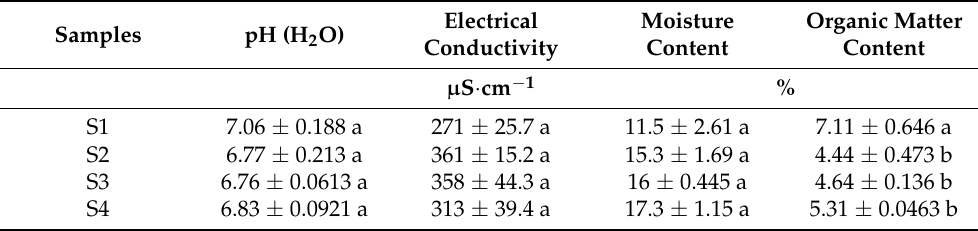
Table 1. Soil analyses (samples collected at depth of 0–30 cm) of Triticum aestivum L. experimental field’s pH, electrical conductivity, organic matter, and moisture contents ( n = 3). Letters a, b indicate significant differences of each parameter, considering different samples (statistical analyses using the single-factor ANOVA test, p < 0.05).